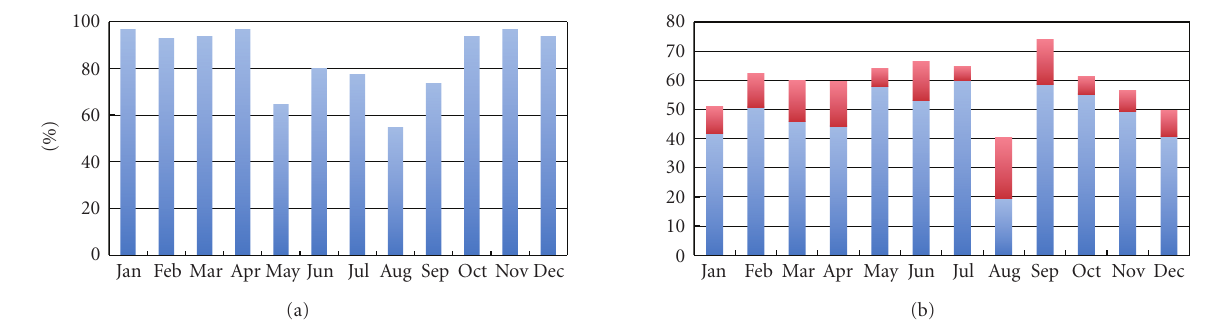
Figure 6: La Silla good nights of year 2008. (a) The percentage of nights with more than 6 hours of opening for REM dome: it may be considered very close to good weather nights in La Silla. (b) The shutter-open time percentage for REM cameras: red portions are the Observing Blocks ending with some error status which are to be repeated. No overheads have been included in this plot. The month of August included a two-week maintenance mission which makes those data